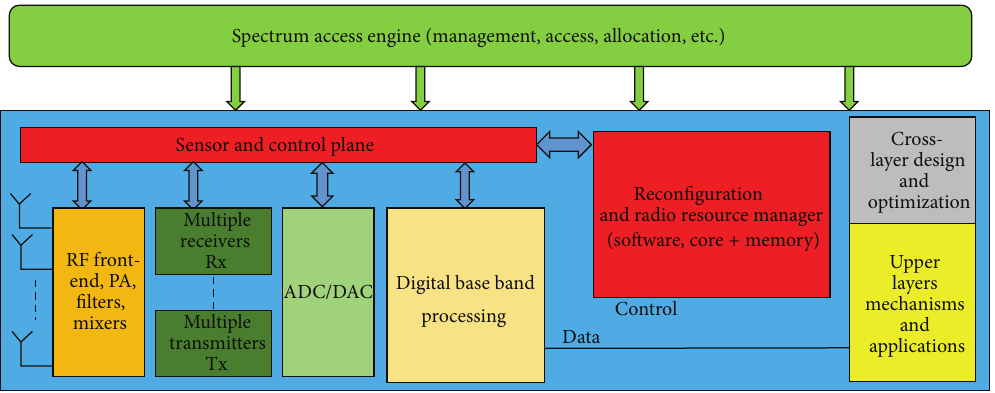
Figure 8: The spectrum access scheme including RF